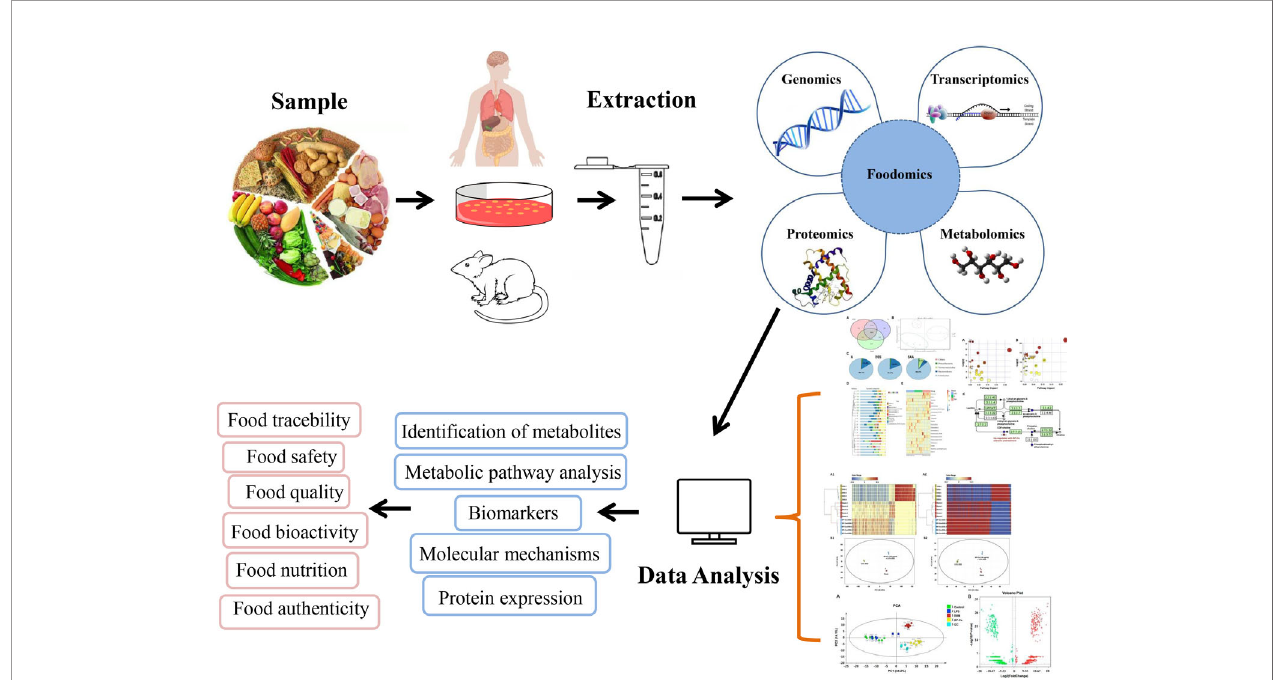
FIGURE 2 | Foodomics-application in food sciences. Research priorities and fi ndings in food science are described intuitively in the form of visual data and graphs using foodomics